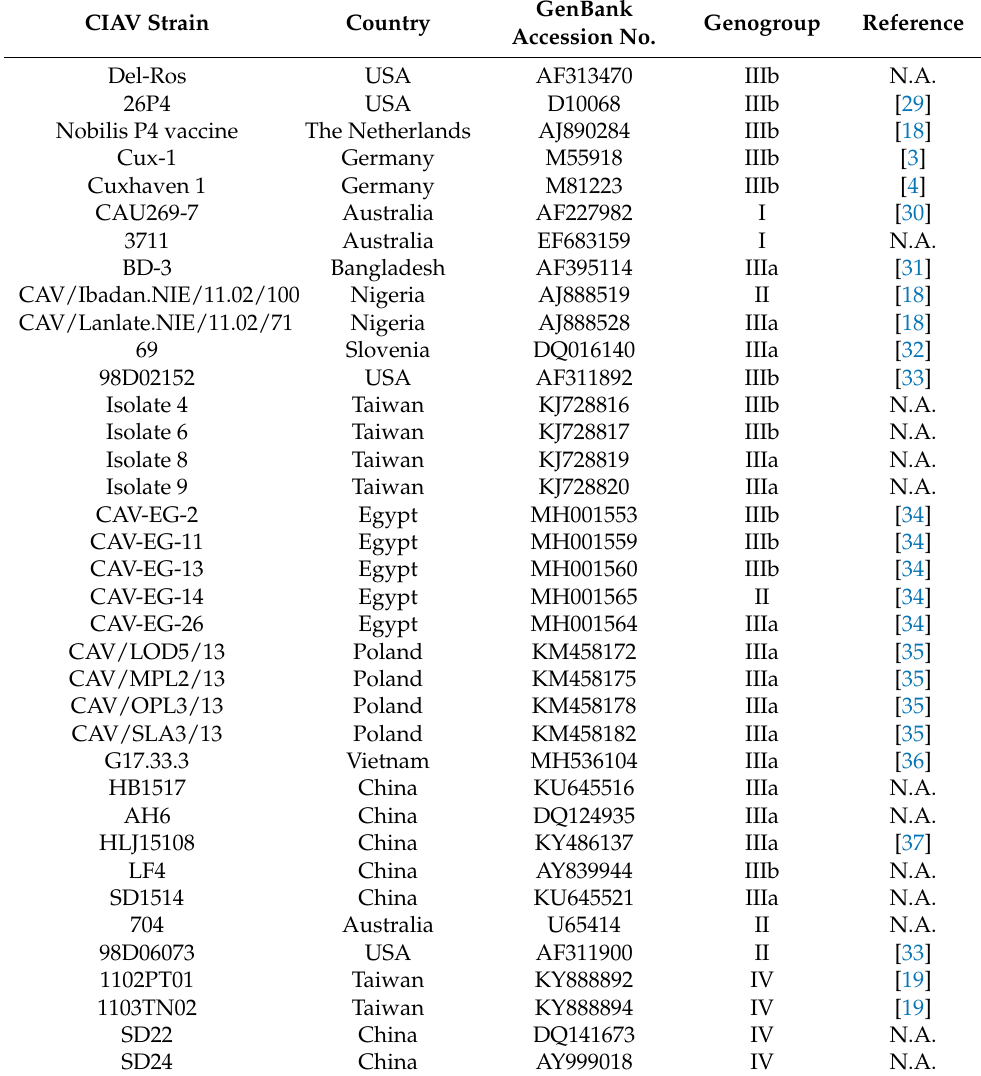
Table 3. Reference strains retrieved from the GenBank database included in the